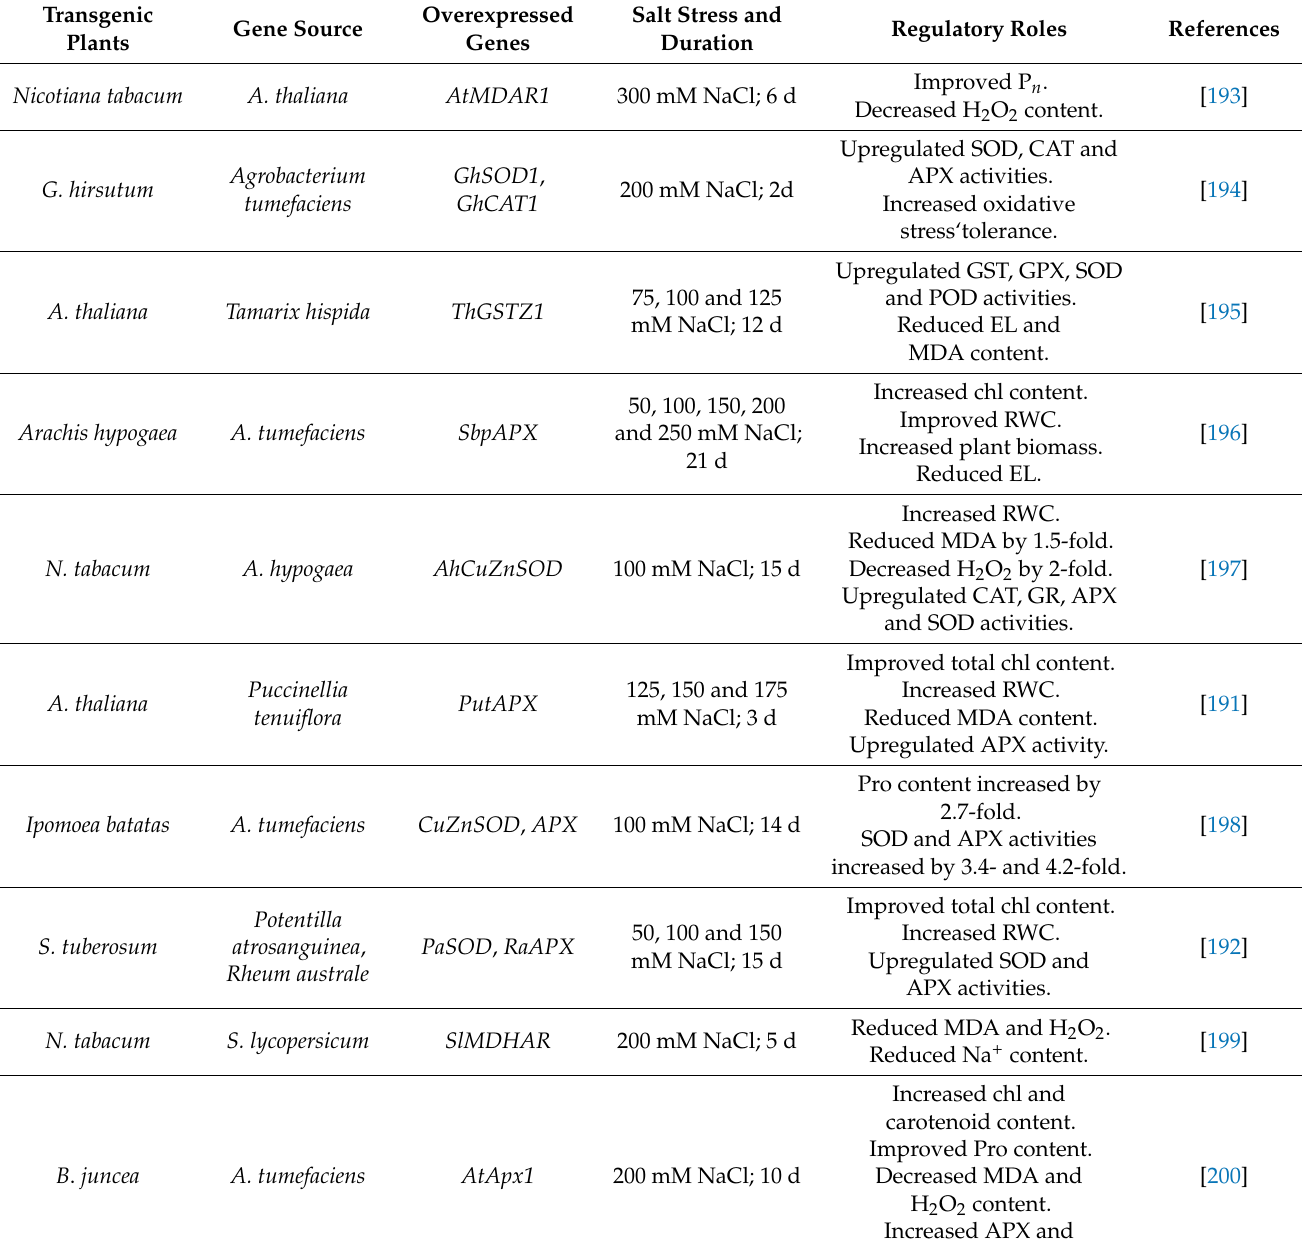
Table 3. Effects of overexpressed antioxidant genes under salinity in different